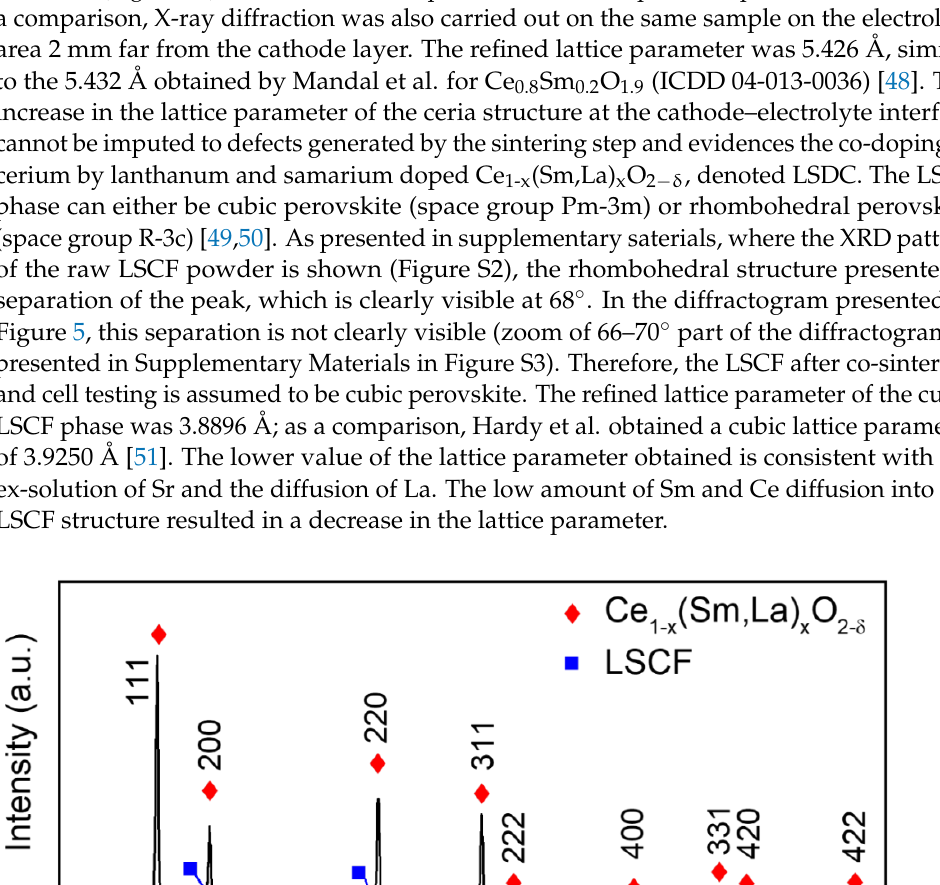
Energies 2021 , 14 , x FOR PEER REVIEW 8 of 16 Figure 4. BSE-SEM micrograph of the cathode–electrolyte interface after selective dissolution of